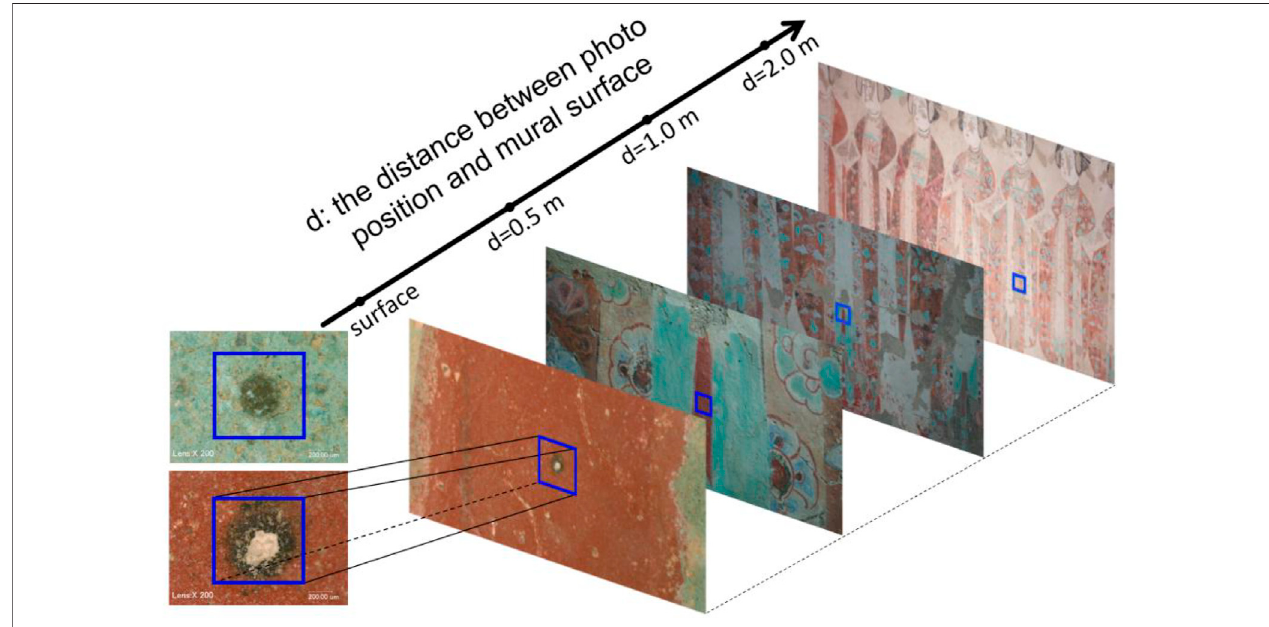
FIGURE 4 | Photographs of laser-ablated area after fi ve laser pulses on the same spot at different distances from the surface.